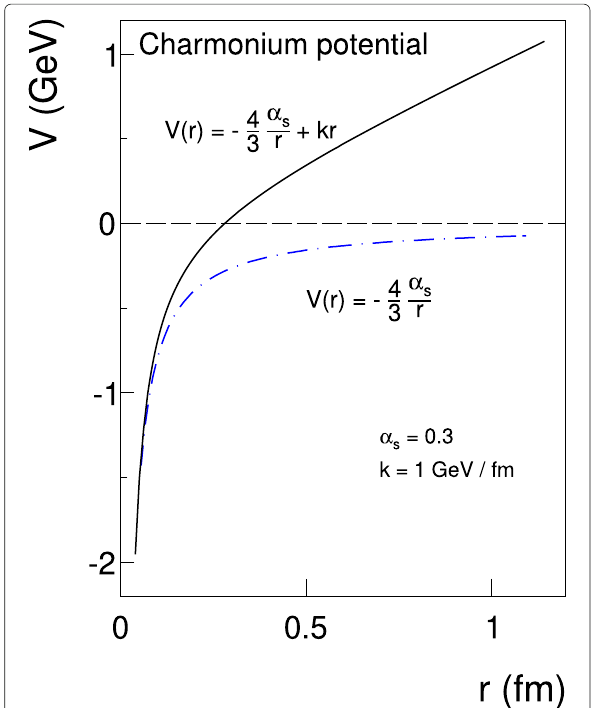
Fig. 1 The potential between c and ¯ c for a charmonium